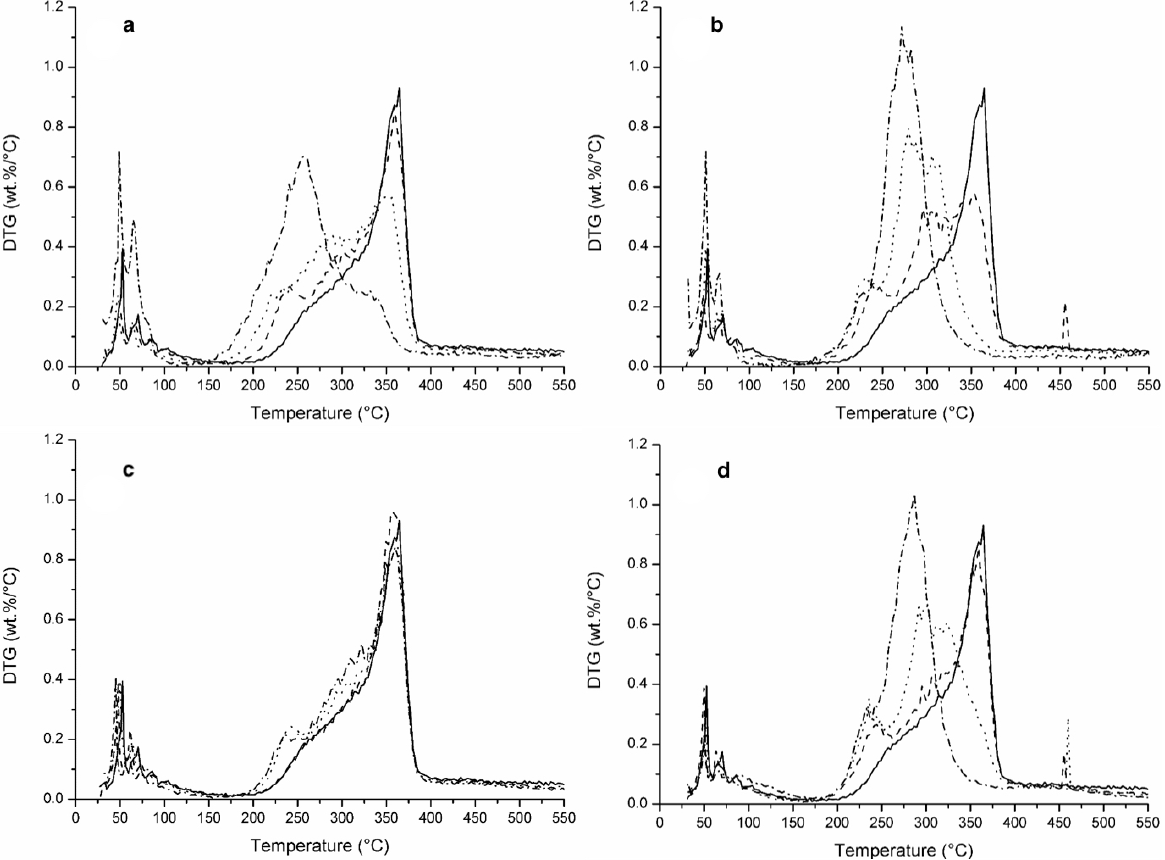
Figure 2. DTG of soybean hull treated with [bmim][Ac] ( a and c ), and [bmim][Cl] ( b and d ), for 2 h ( a and b ), and 6 h ( c and d ). Legend: (—) untreated biomass, (----) IL 50 % and 75 °C, (. . . .) IL 100 % and 75 °C, and (-.-.-.) IL 100 % and 100